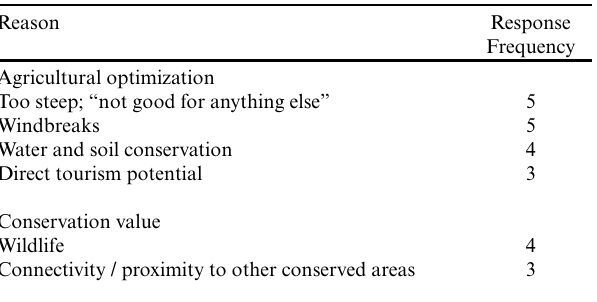
Table 4. Reasons for allowing forest regrowth (afforestation) and planting trees (reforestation) on farms. “Response frequency” indicates the number of people interviewed who mentioned the item in their responses.